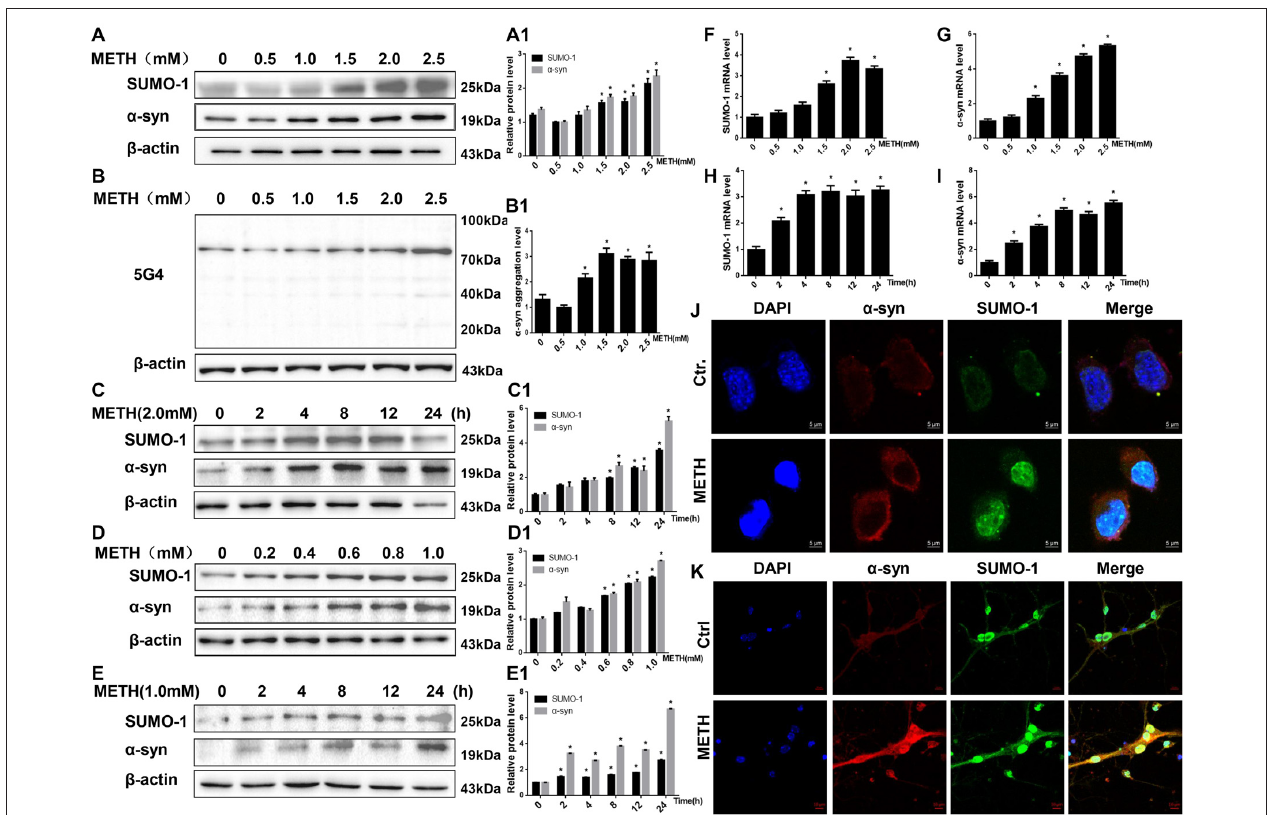
FIGURE 1 | Methamphetamine (METH) increases small ubiquitin-related modifier 1 (SUMO-1) and alpha-synuclein ( α -syn) protein expression in vitro . METH exposure up-regulates the protein expression of SUMO-1, α -syn and the aggregation of α -syn in a dose-dependent and time-dependent manner in SH-SY5Y cells and primary cultured neurons. SH-SY5Y cells were exposed to 0.5 mM-2.5 mM METH for 24 h (A,B,A1,B1) and 2.0 mM METH for 2–24 h (C,C1) . Primary cultured neurons were exposed to 0.2–1.0 mM METH for 24 h (D,D1) and 1.0 mM METH for 2–24 h (E,E1) . Western blot (A–E) and quantitative analyses (A1–E1) were performed